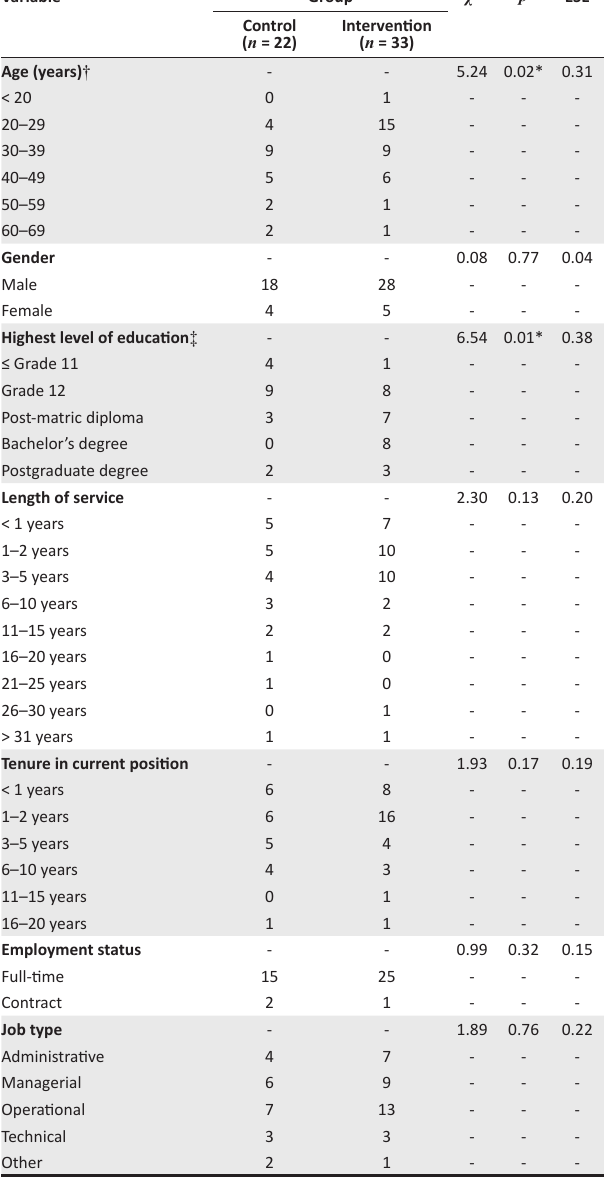
TABLE 2: Sample socio-demographic characteristics ( N = 55).